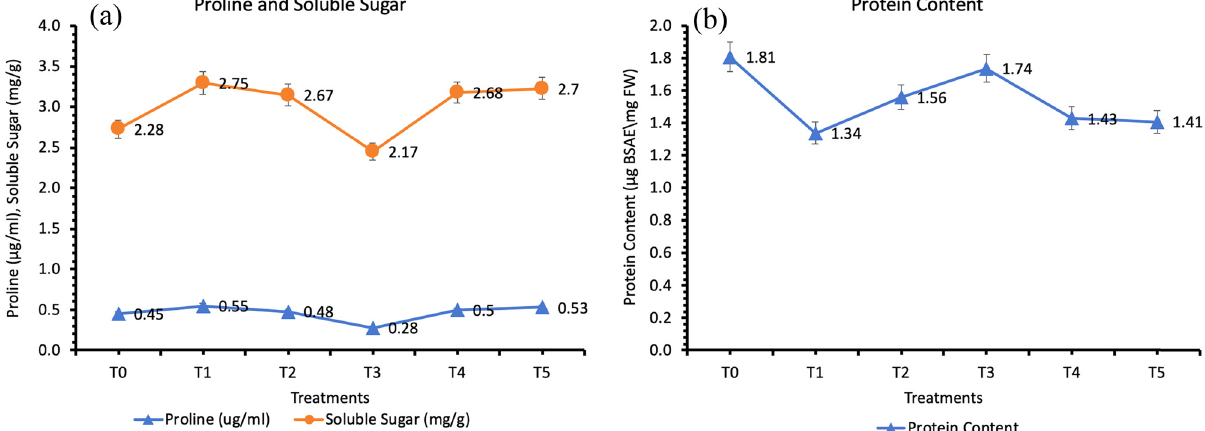
Figure 4: E ff ect of di ff erent treatments of AgNPs on nonenzymatic parameters of rice plants under biotic stress: ( a ) total proline content and total soluble sugar contents and ( b ) total protein content. Note: T0: control; T1: A. fl avus ( pathogen ) ; T2: 25 mg/L of AgNPs + A. fl avus ; T3: 50 mg/L of AgNPS + A. fl avus ; T4: 75 mg/L of AgNPs + A. fl avus ; T5: 100 mg/L of AgNPs + A. fl avus